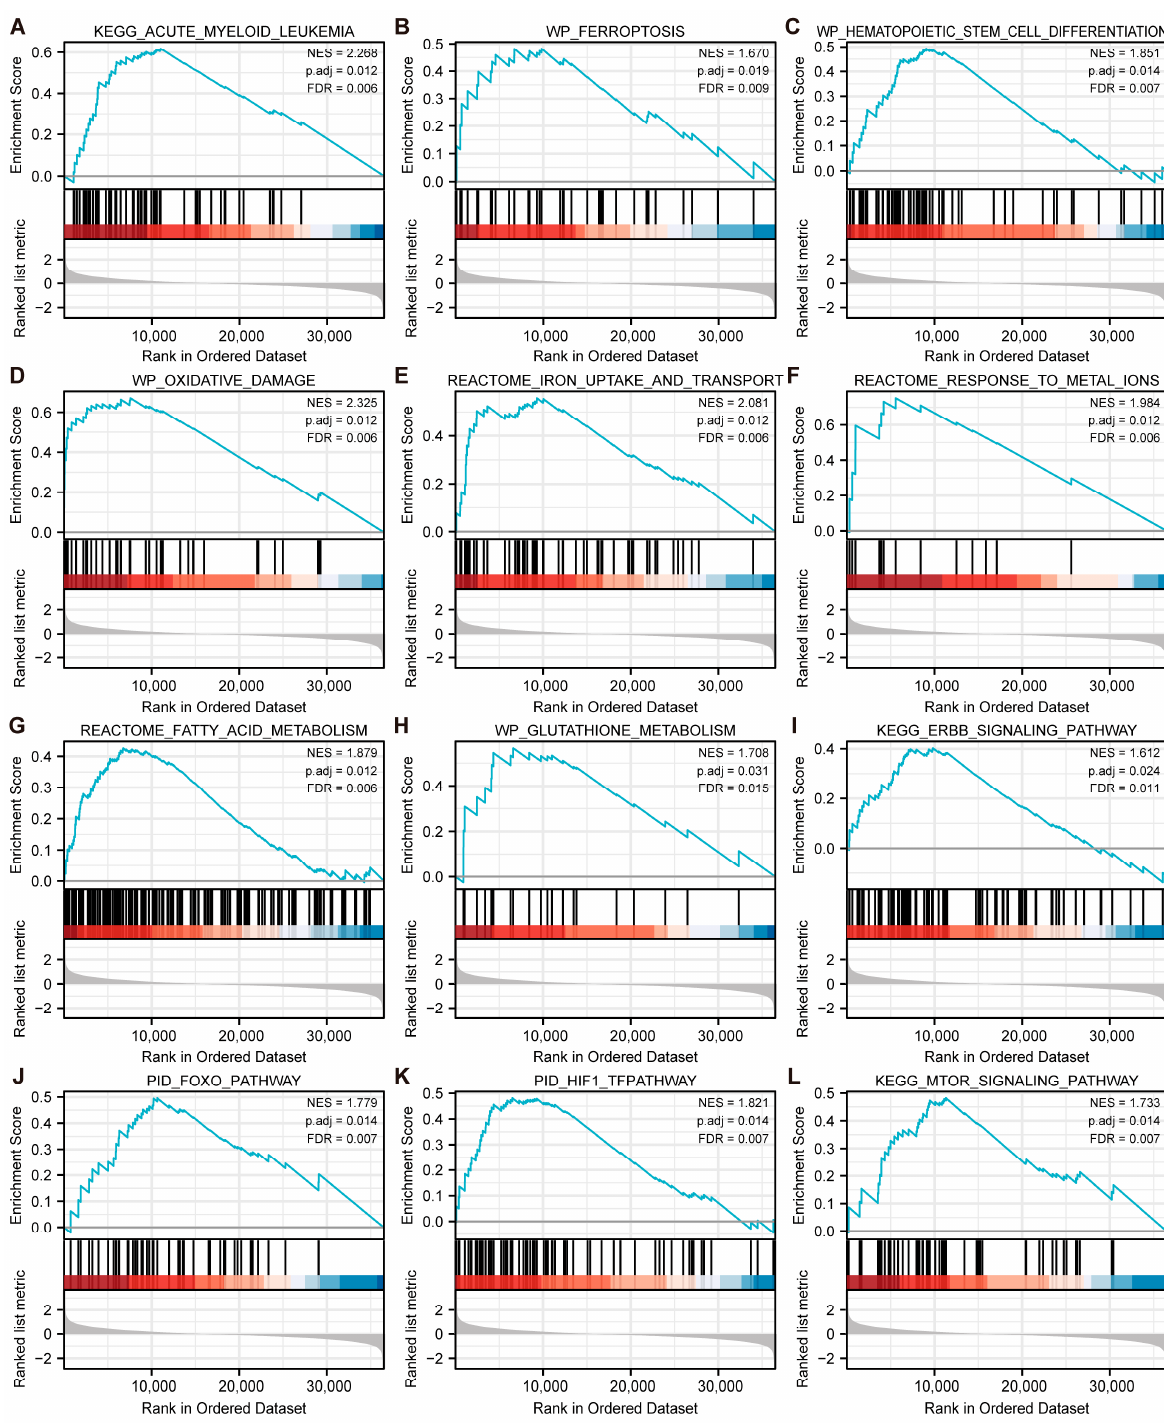
Figure 6. GSEA enrichment analysis of MAPK3. ( A – L ) Identification of the biological functions of MAPK3. Upregulated genes are located on the left, approaching the origin of the coordinates, whereas downregulated genes are on the right of the X-axis. Only gene sets with false discovery rate (FDR) < 0.25 and adj. p < 0.05 were considered significant.